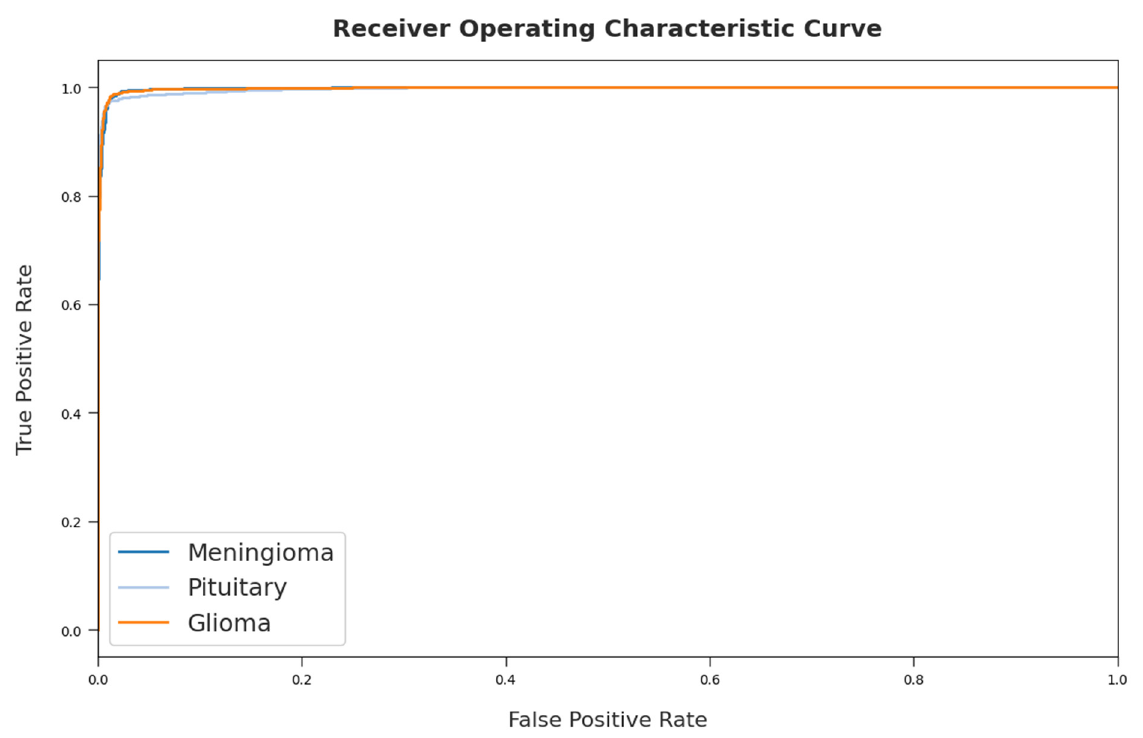
Figure 9. ROC curve analysis of EADL-BTMIC technique.